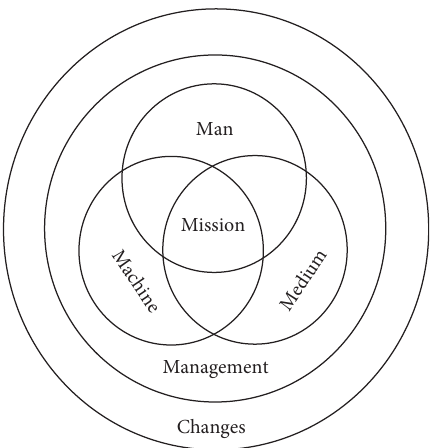
Figure 2: SCOHI-5M1C model.